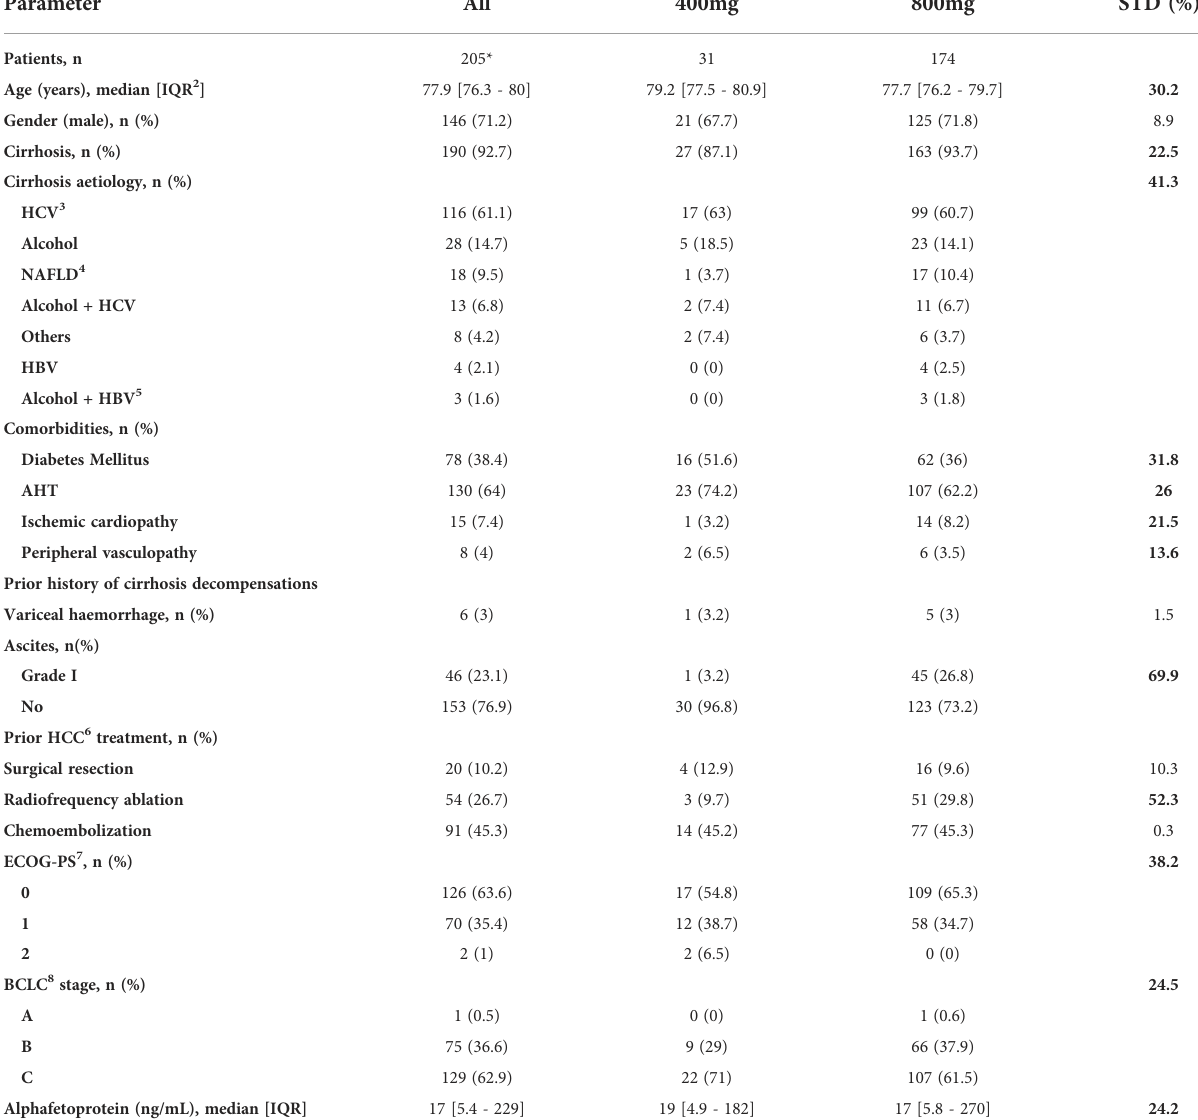
TABLE 2 Population baseline characteristics according to initial sorafenib dose. Parameter